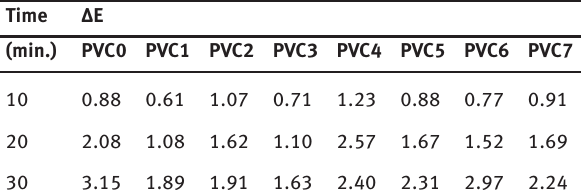
Table 5: The colour change of composites obtained from the oven test.